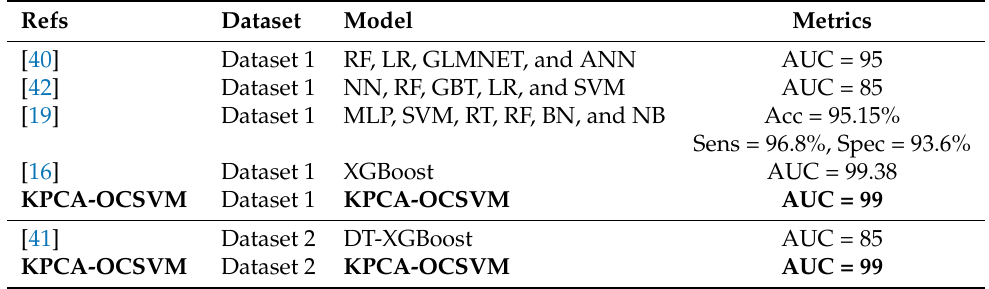
Table 6. Comparison with existing